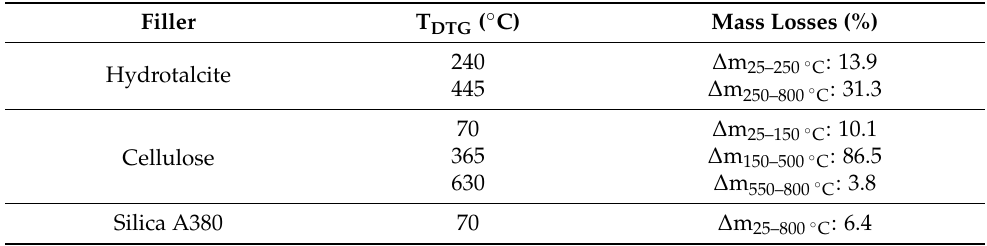
Table 4. Thermal stability of pure fillers (T 5% , decomposition temperature at 5% of the mass